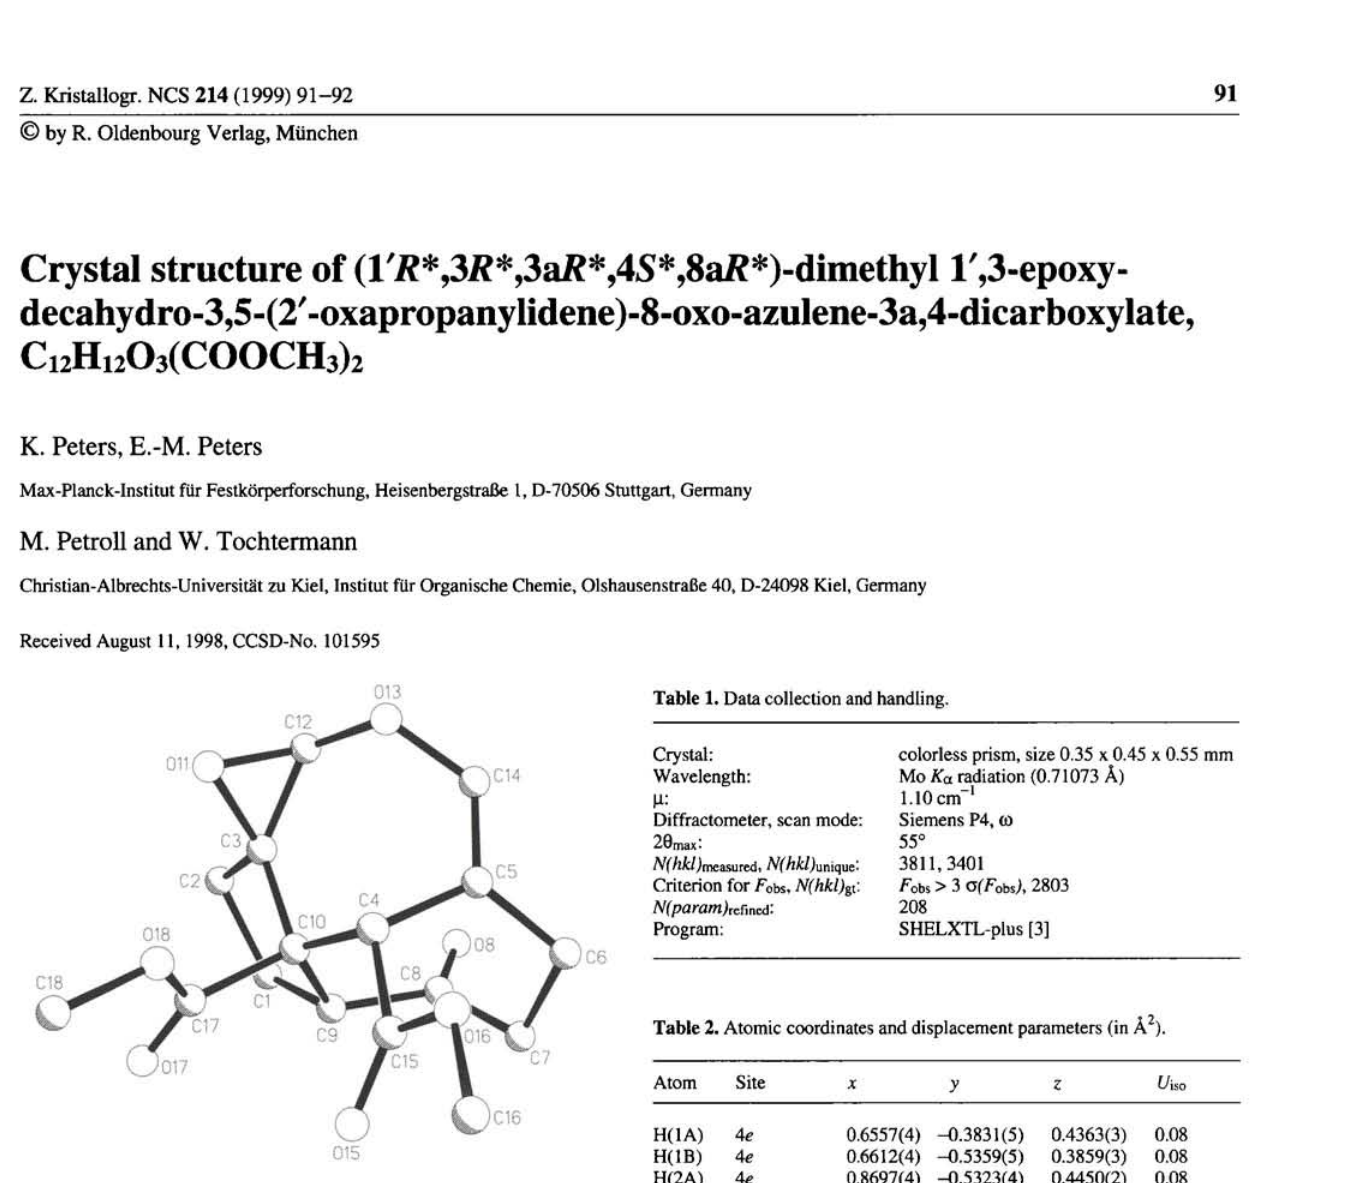
Table 2. Atomic coordinates and displacement parameters (in À 2